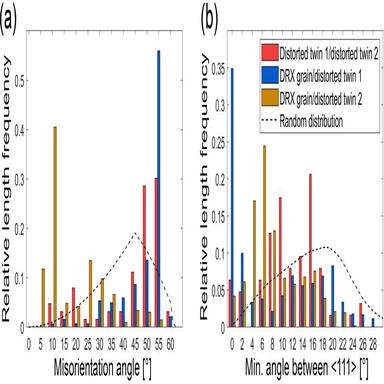
Results of the GB misorientation analysis of DRX grains that nucleated at distorted twins in solutionised and aged Alloy 1 deformed at 1050 ◦C with a 0.1 s − 1 strain rate to 0.6 strain. (a) shows the misorientation angle distribution and (b) the minimum (min.) angle between the closest 〈111〉 crystal directions. The GBs between DRX grains and deformed grains with higher misorientation angle ('1′ ) are shown in blue, the ones with lower misorientation angle ('2′ ) in yellow. The mean misorientations between